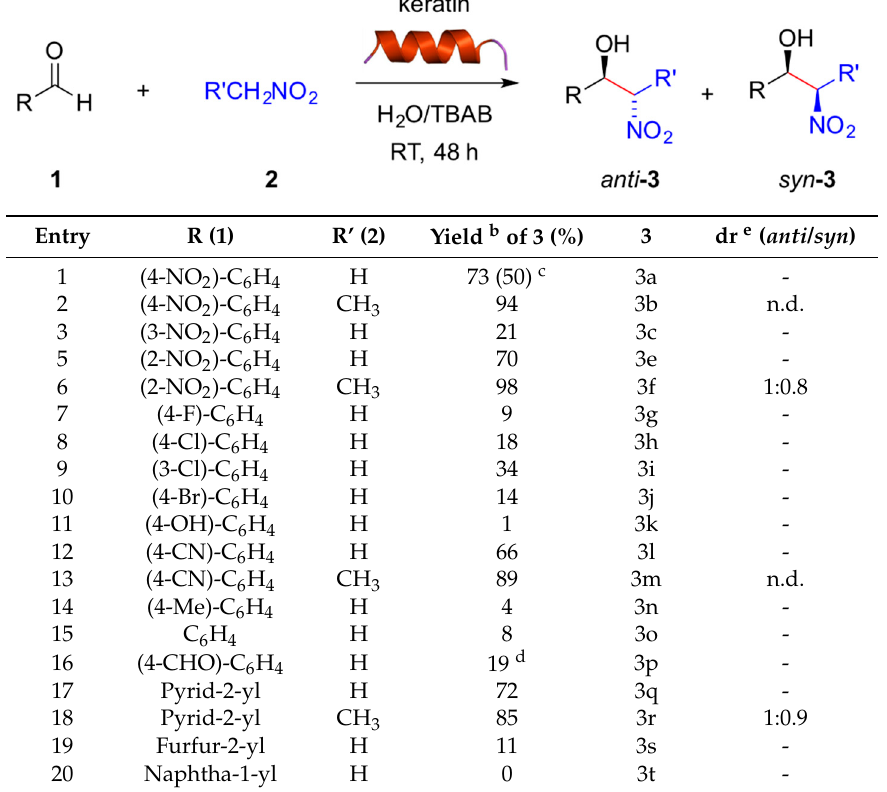
Table 3. Keratin-catalyzed nitroaldol (Henry) reaction in H 2 O/tetrabutylammonium bromide (TBAB) a .